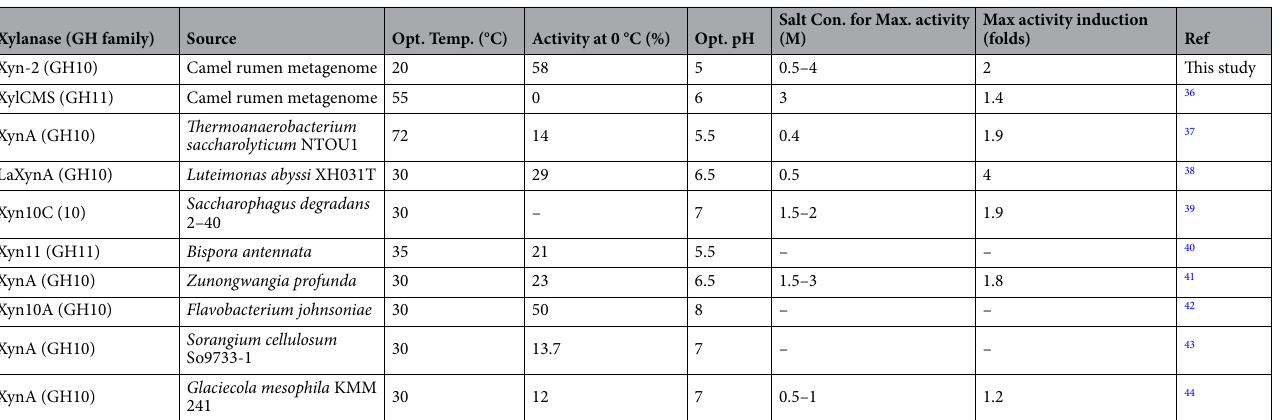
Table 1. Comparison of optimum temperature, pH, and NaCl concentration between Xyn-2 and other cold- adapted and/or halophilic xylanases. GH family glycoside hydrolase family, Opt. optimum, Temp. temperature, Con. Concentration, M molarity, Max